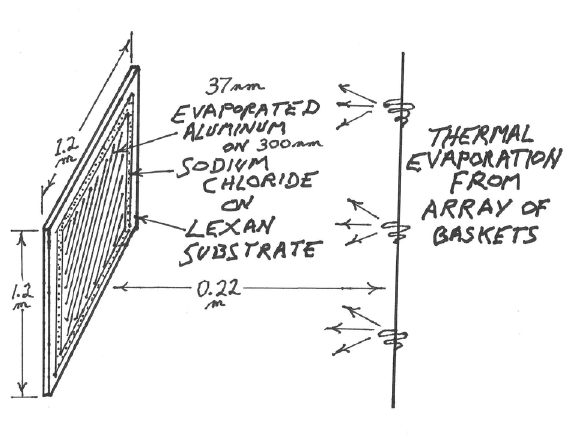
Fig. 1: Simplified sketch of evaporation method for NaCl and Al.